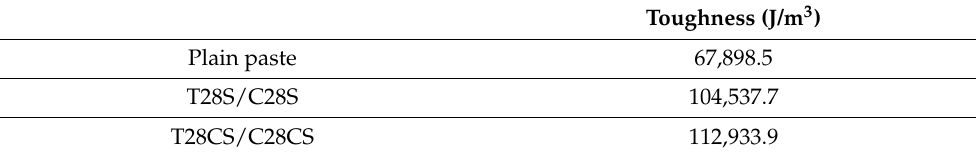
Table 7. The 28-day toughness (J/m 3 ).